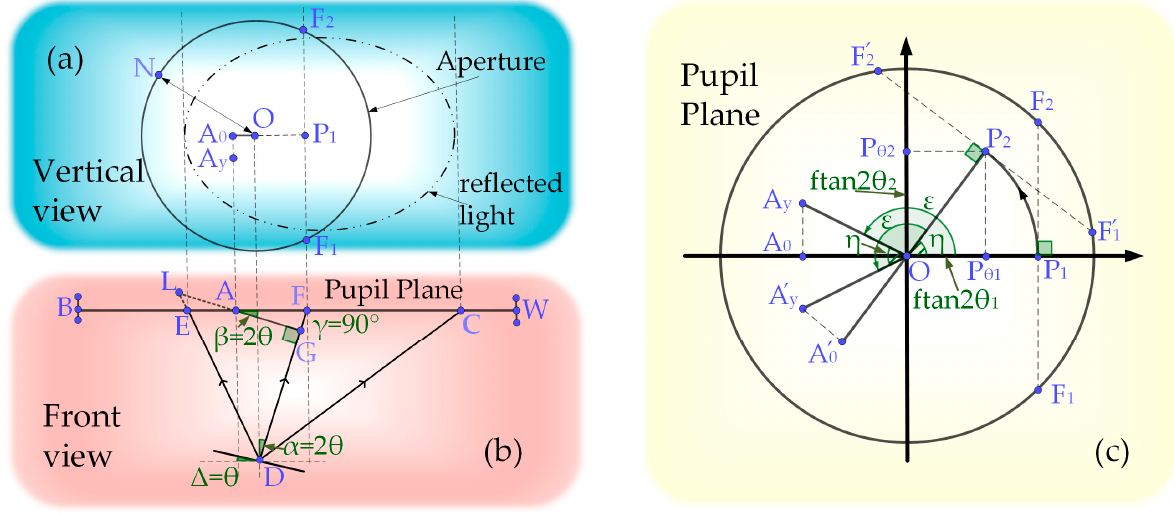
Figure 3. Ray tracing of the returning beam on the object side of the microscope during a 1D tilt illustrating ( a ) the top and ( b ) front views; ( c ) conversion relationship between 1D and two-position tilts.